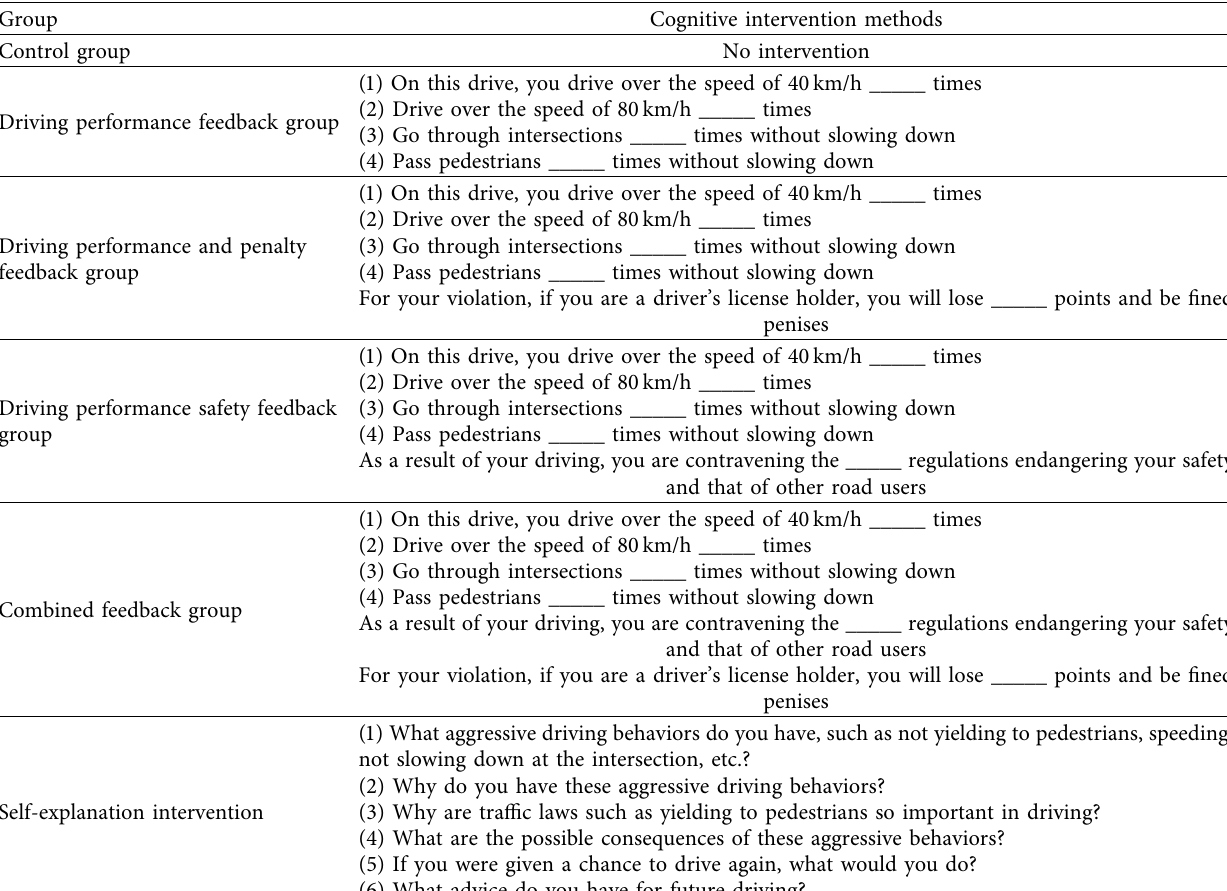
Table 2: Explanation of cognitive intervention methods.